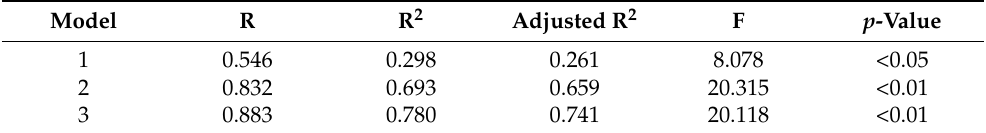
Table 7. A stepwise multiple regression to estimate the association between integration, mean depth, cognitive ability, and